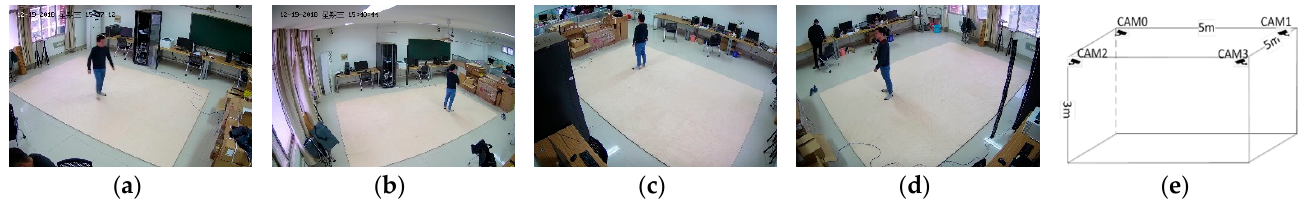
Figure 4. The layout of cameras. CAM0 and CAM2 are placed at near the window, with the lens back to the window. CAM1 and CAM3 are placed away from window and the lens are facing the window: ( a ) CAM0; ( b ) CAM1; ( c ) CAM2; ( d ) CAM3; ( e ) shows the space size of the scence and the layout of cameras in the scence.